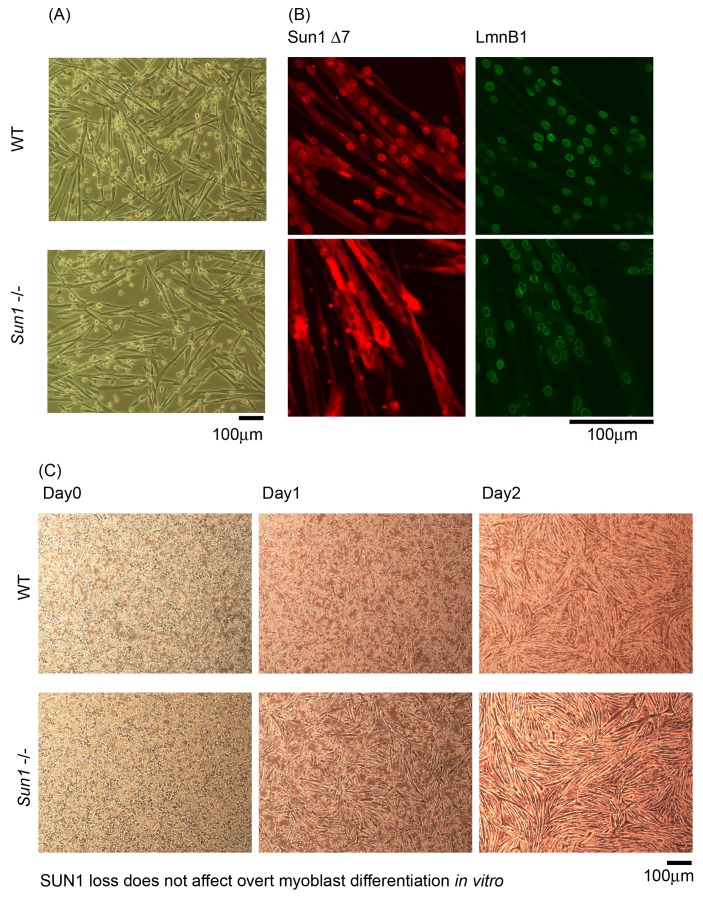
Sun1 expression in differentiating myoblast cultures.(A) The in vitro differentiation of primary myoblasts derived from Sun1–/– and WT hind-limb muscle is similar. (B) Confocal immunostaining with SUN1Δ7 and Lamin B1 antibodies; SUN1Δ7 isoforms localize to the NEs of WT and are absent in the Sun1–/– myotubes. (C) In vitro differentiation of primary myoblasts at three time-points showing no overt differences in myotube formation.